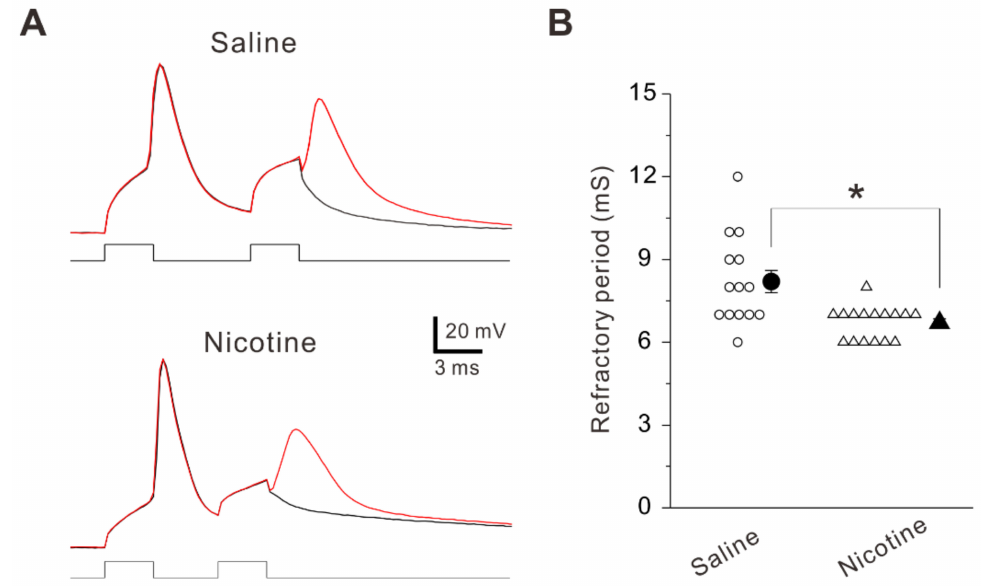
Figure 5. Effects of adolescent nicotine exposure on spike refractory period. ( A ) Sample traces of voltage responses to two successive current pulses obtained from PNs of a saline-treated mouse (top) and a nicotine-treated mouse (bottom). ( B ) Summary data of refractory period obtained from PNs of saline-treated mice (n = 14 neurons/6 mice) and nicotine-treated mice (n = 16 neurons/7 mice). Unpaired t -test, *: p =